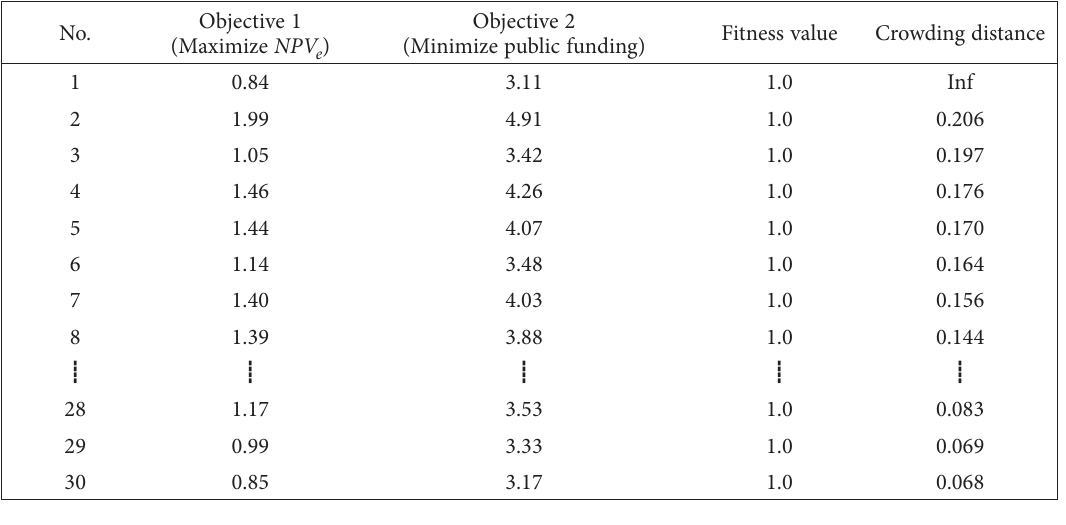
Table 6. Model results: optimization results of two sub-objectives (billion $)